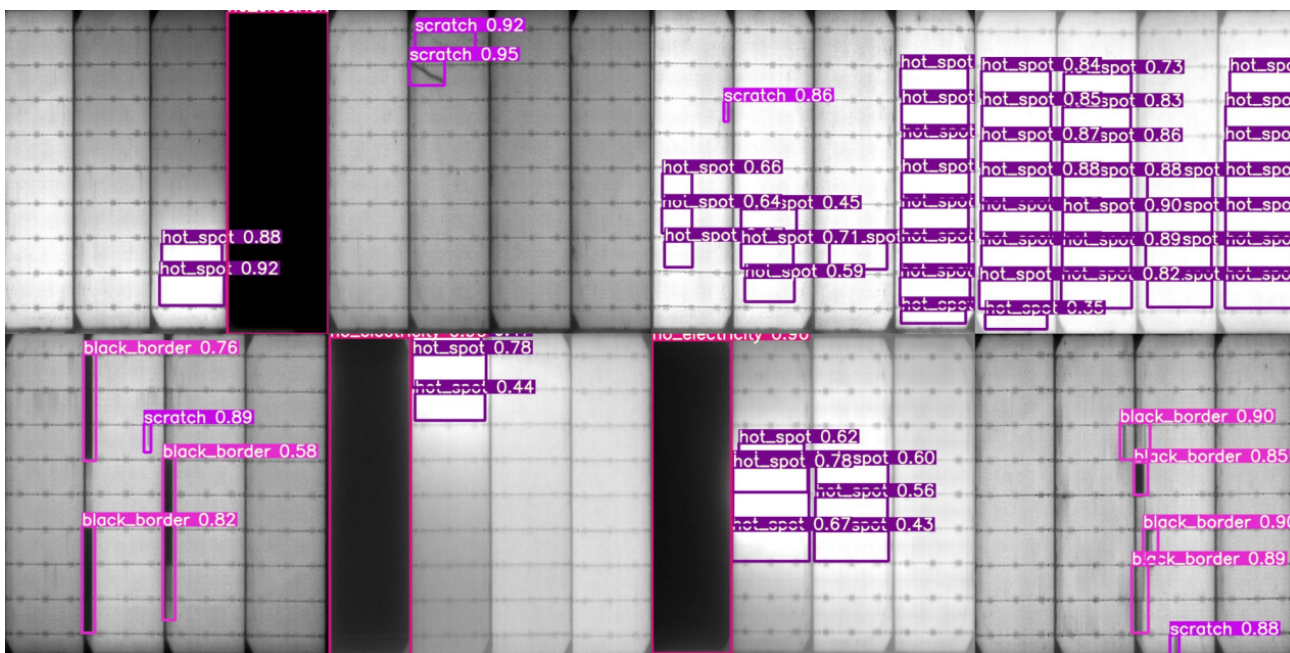
Figure 8. Surface defect identification results of PV